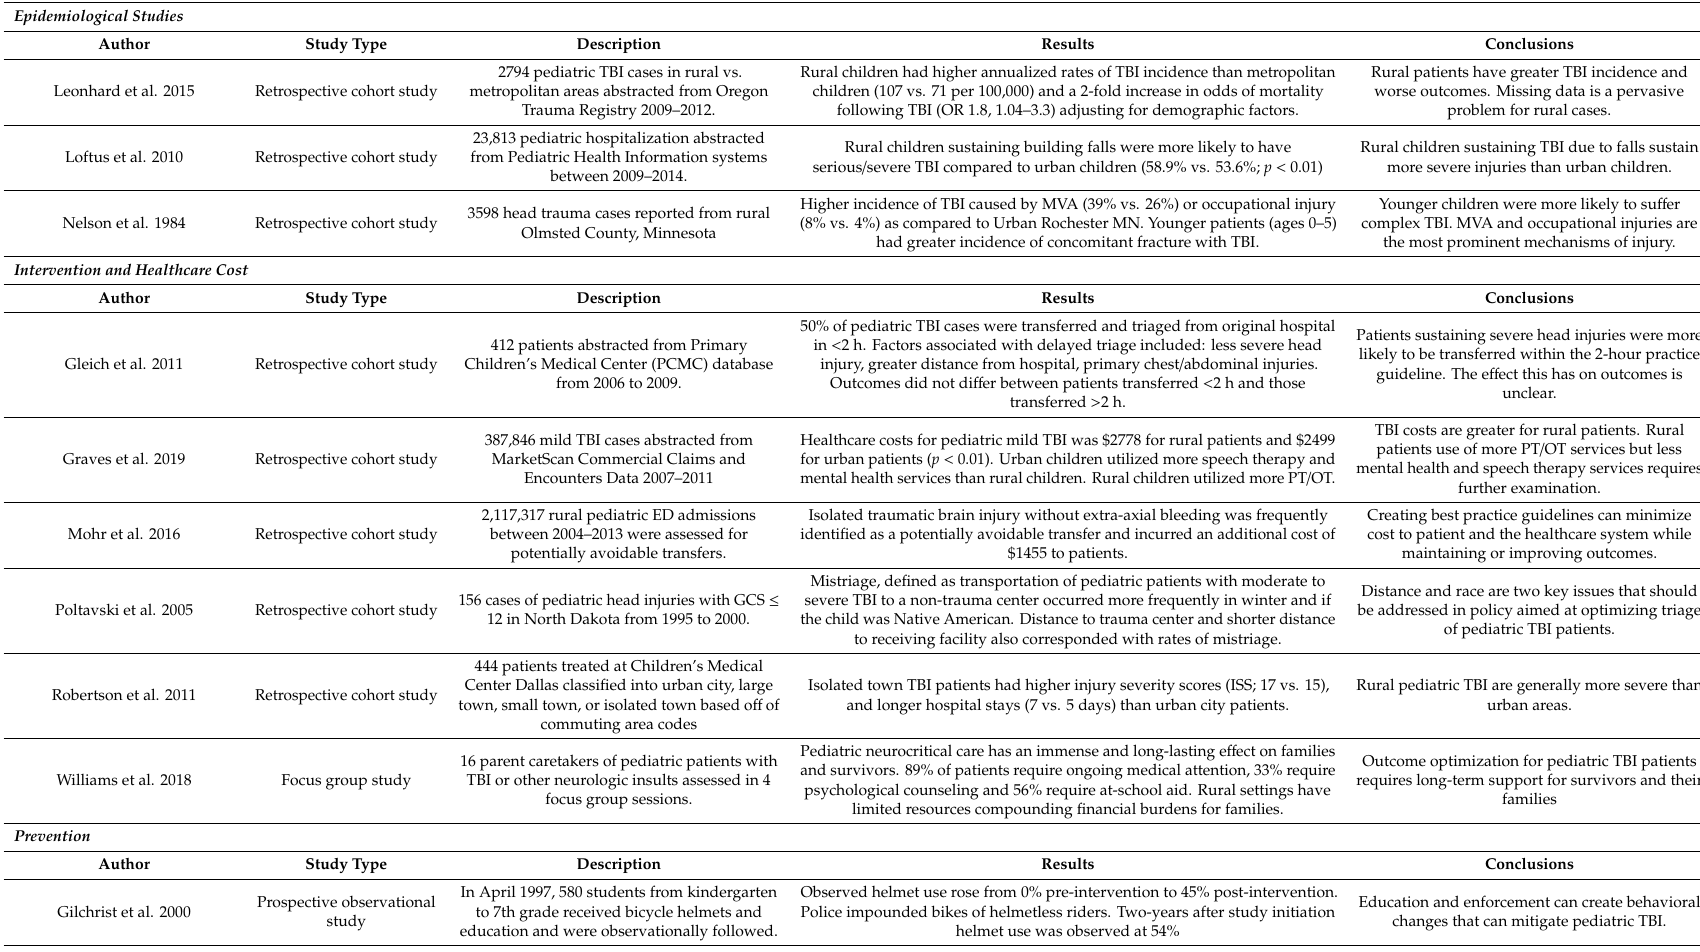
Table 1. Summary of